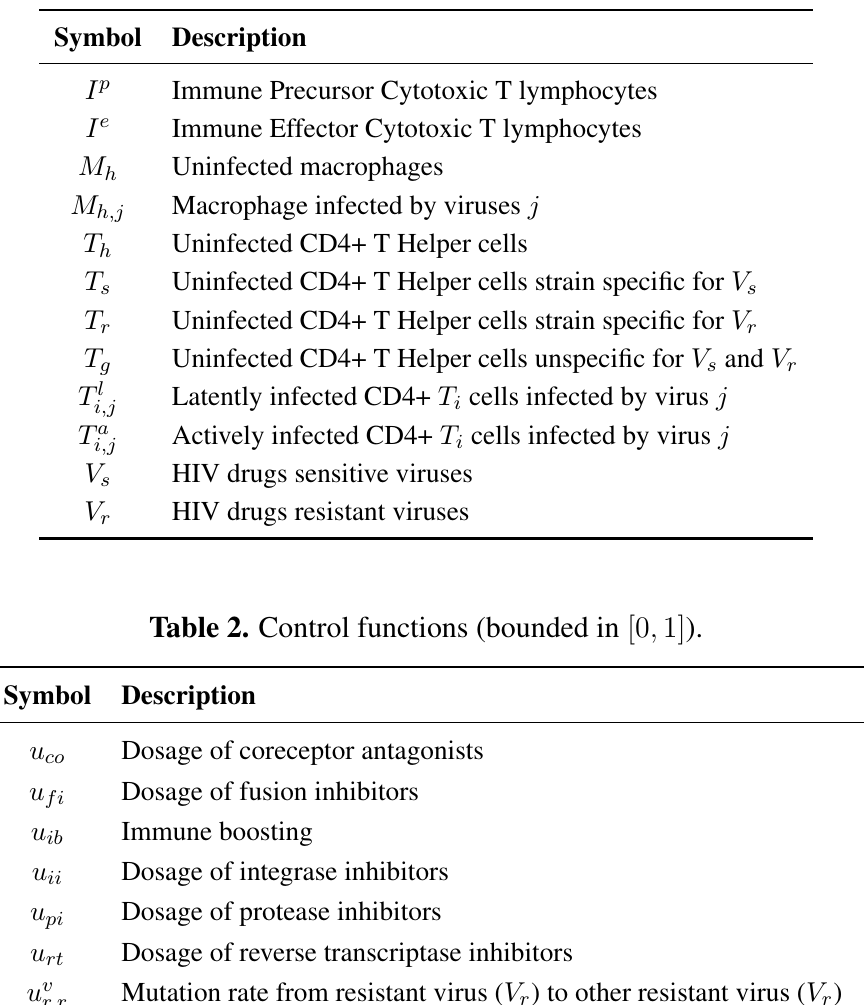
Table 1. State functions (Unit of measure: cells/mm 3 ).